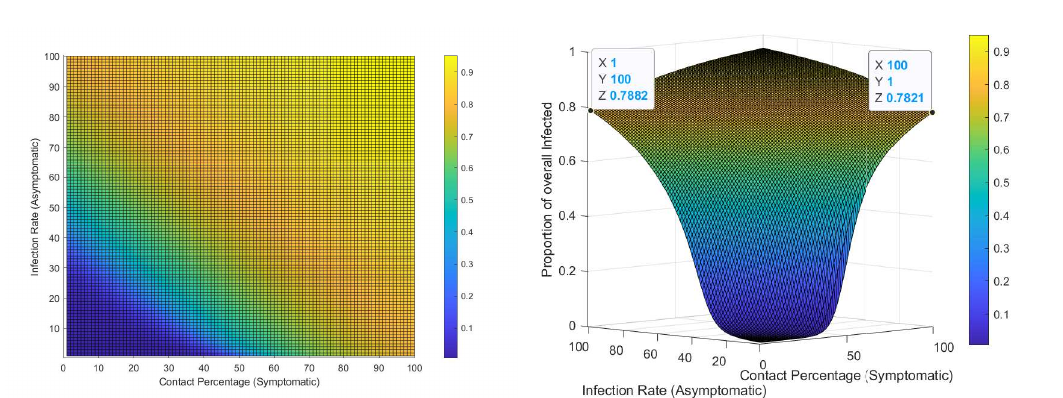
Figure 4. Infection rate for asymptomatic vs. symptomatic contact percentage on overall sickness rate.